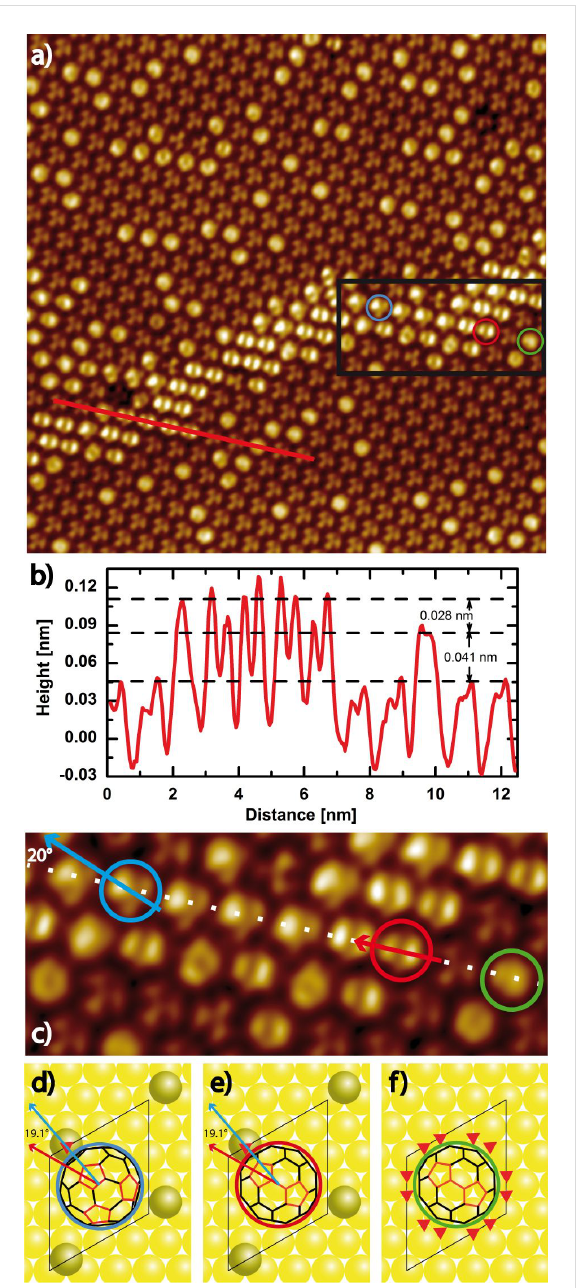
Figure 4: (a) High resolution STM Image (24 × 24 nm 2 ) of a stripe structure ( U bias = 0.63 V, I T = 0.07 nA, slightly low pass filtered, sample A3). (b) The linescan shows the apparent height difference (0.028 nm) between en-bright C 60 molecules within the stripe and bright C 60 molecules within the dis-R30° structure at U bias = 0.63 V. (c) Enlarged STM image of the C 60 -stripe structure marked by a black rectangle in Figure 4a. (d–f) Top view models of selected C 60 mole- cules on the Au(111) surface marked by colored circles in Figure 4a and Figure 4c. (d) C 60 in 5:6-top position (encircled in blue) with a mirror plane rotated by about 20° referenced to the red C 60 . (e) One three-fold hollow site is occupied by an adatom next to the 6:6-top C 60 (encircled in red). (f) 6:6-top C 60 characteristic for the dis-R30° struc- ture, encircled in green. All available three-fold hollow sites around this C 60 are indicated by red